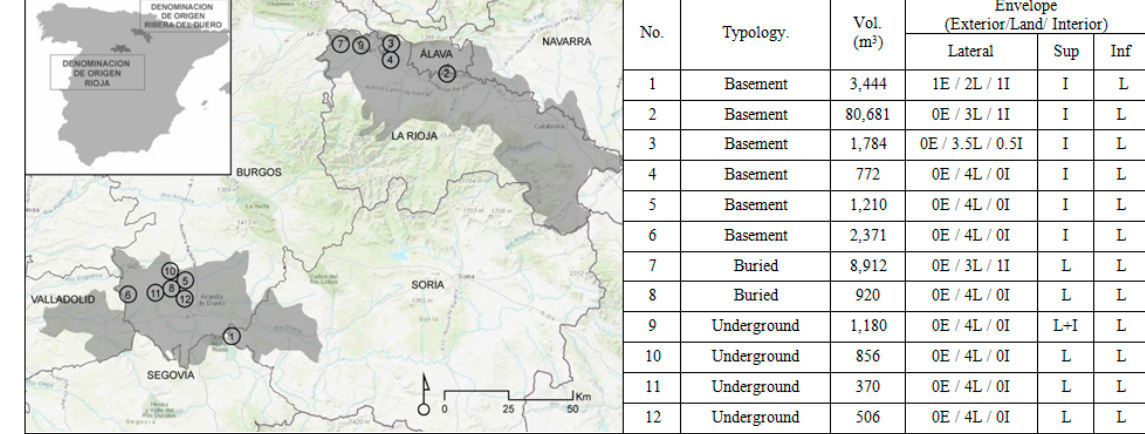
Figure 1. List and location of monitored aging rooms.